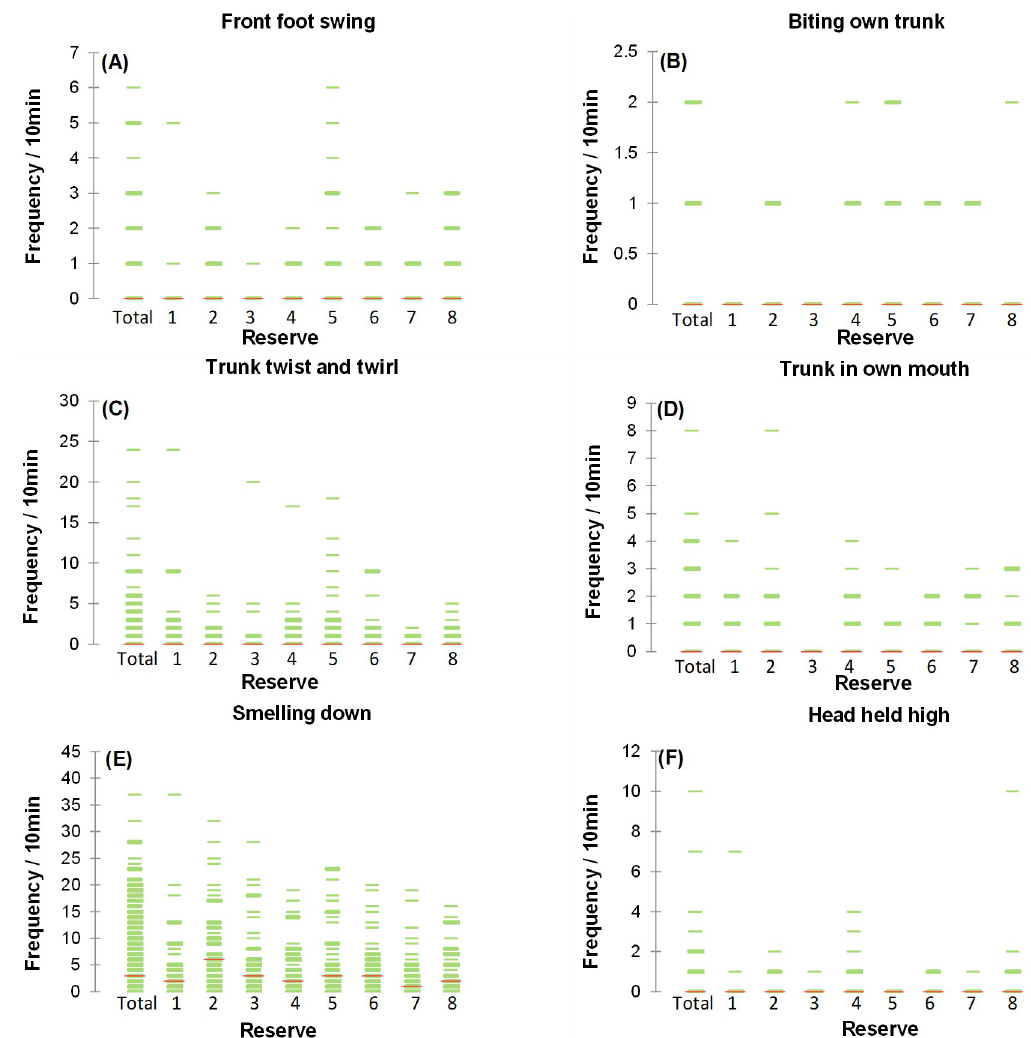
Fig 1. Strip plots that illustrate the influence of reserve on the frequency of the (A) Front foot swing, (B) Biting own trunk, (C) Trunk twist and twirl, (D) Trunk in own mouth, (E) Head held high and (F) Smelling down behaviours. The lines represent the distribution of frequencies observed for each focal sample and are plotted along the y-axis (for a given interval, the thicker or more tightly packed the strips, the more data there is).